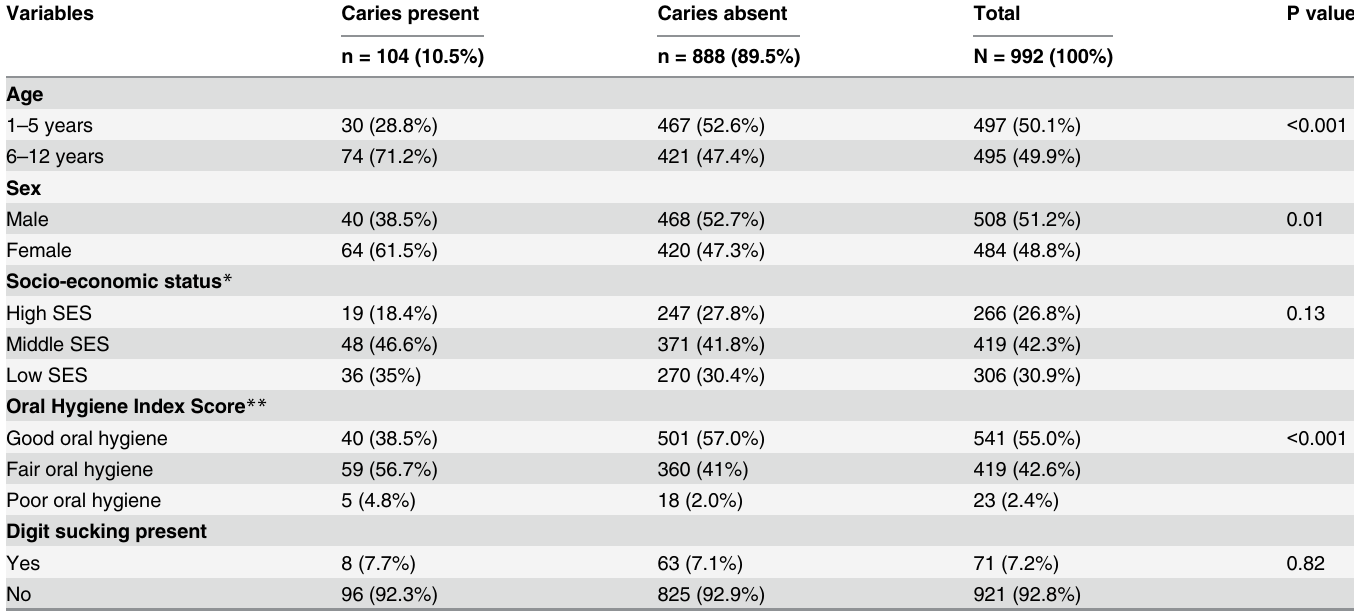
Table 2. Caries profile of study participants (N =